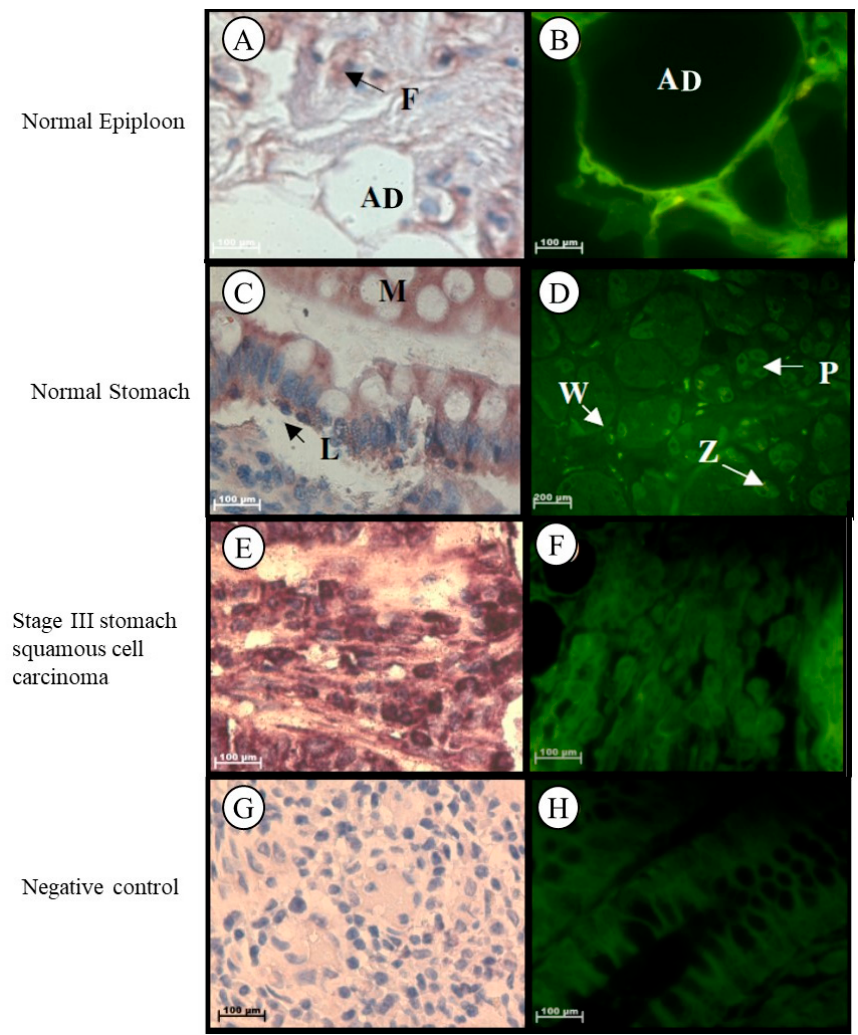
Figure 2. Subcellular Localization of Tspo mRNA in healthy and diseased stomach tissue: In normal epiploon tissue ( A , B ) Tspo mRNA is found in adipose cells (AD) as well as in fibroblasts (F). In healthy stomach Tissue ( C , D ) Tspo mRNA is localized in the cytoplasm of parietal cells (P), chief cells (Z), surface mucous cells (M) of the gastric glands and in the cytoplasm of plasma cells (P) and macrophages (W) and nuclei and cytoplasm of lymphocytes (L) located in the lamina propria. In stomach squamous cell. carcinoma ( E , F ) Tspo mRNA is localized in the cytoplasm of tumour cells and collagen fibres in the surrounding stroma. ( G , H ) Negative control for the subcellular localization of Tspo mRNA. Sense probes were used to probe tissue preparations and this was analysed colorimetrically and fluorescently . Tissues are magnified at 1000×.